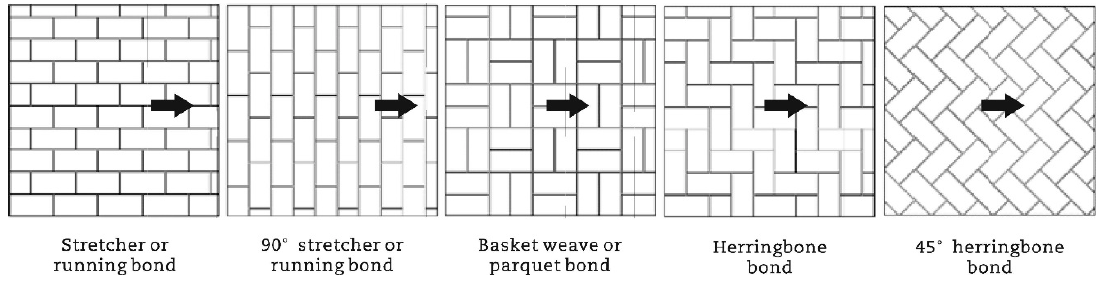
Figure 5. Block patterns.